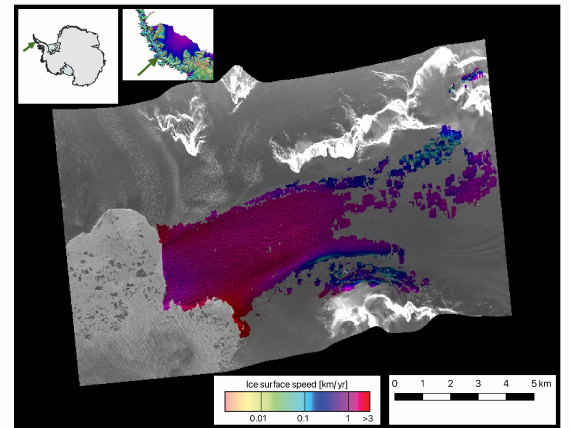
Figure 3. Feature tracking result of imagery from Capella Space over Murphy Glacier, Antarctic Peninsula.